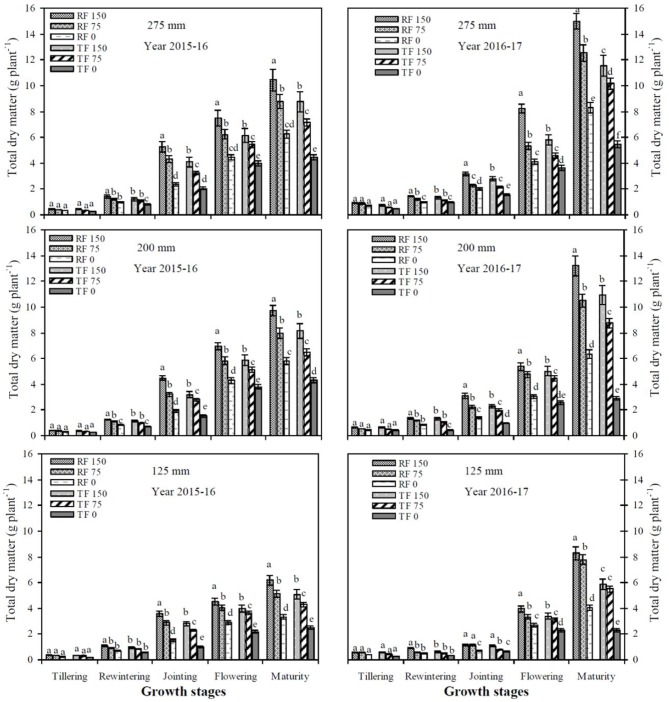
Effects of planting patterns and deficit irrigation on total dry matter accumulation (shoot + root) under simulated rainfall conditions during the winter wheat growing seasons in 2015–2017. RF150: ridges covered with plastic film mulch and 150 mm deficit irrigation; RF75: ridges covered with plastic film mulch and 75 mm deficit irrigation; RF0: ridges covered with plastic film mulch and 0 mm deficit irrigation; TF150: traditional flat planting and 150 mm deficit irrigation; TF75: traditional flat planting and 75 mm deficit irrigation; TF0: traditional flat planting and 0 mm deficit irrigation. Three different simulated rainfall intensity 275, 200, and 125 mm were used. Different lowercase letters indicate significant differences at P < 0.05, and the vertical bars represent the ± the standard error of the mean (n = 3).